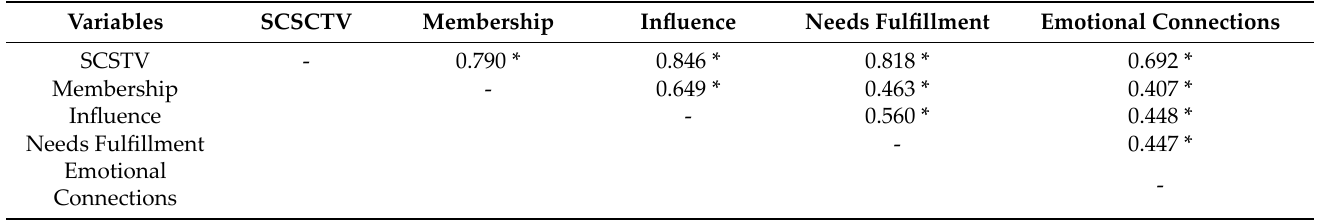
Table 7. Partial correlations between SCSCTV and its